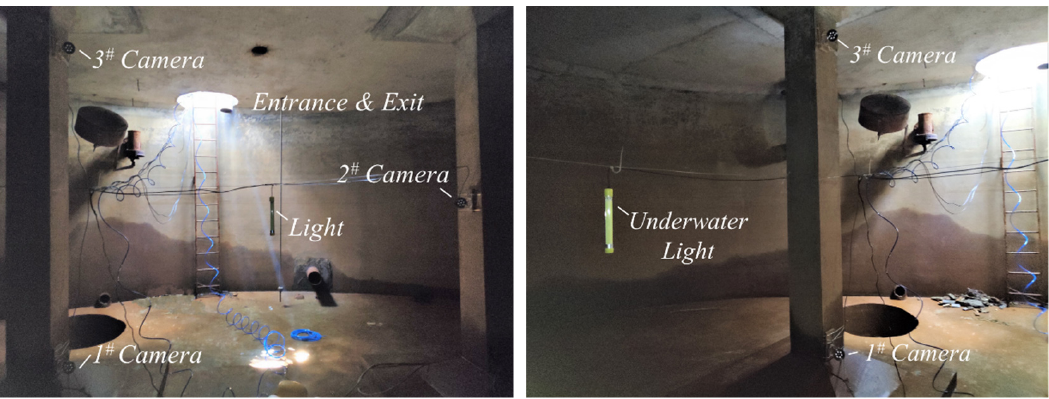
Figure 4. Site con fi guration of the cameras and lighting in the reservoir. Figure 4. Site configuration of the cameras and lighting in the